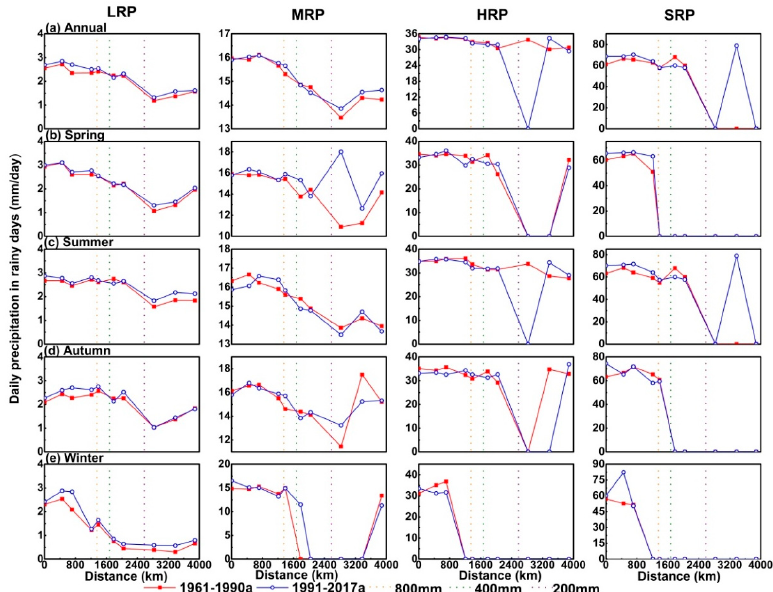
Figure 11. Changes of di ff erent grades of precipitation days with distance from the sea, including light rainfall days (LRD), moderate rainfall days (MRD), heavy rainfall days (HRD), and storm days (SRD). Di ff erent grades of precipitation amount also include annual ( a ) and seasonal (including spring ( b ), summer ( c ), autumn ( d ) and winter ( e )) variations. “800 mm” represents the 800-mm precipitation contour, “400 mm” represents the 400-mm precipitation contour, and “200 mm” represents the 200-mm precipitation contour.